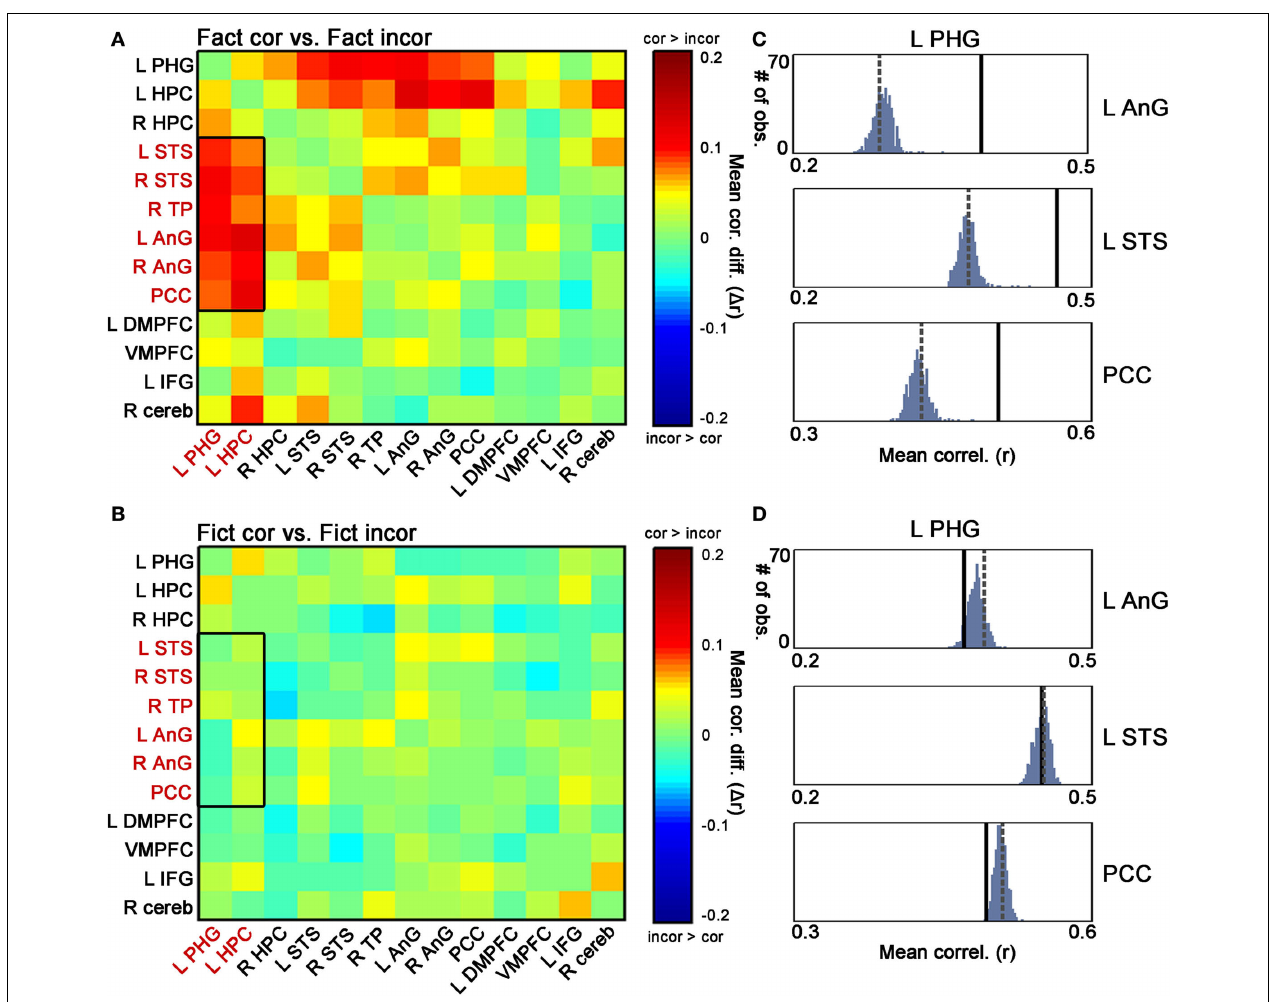
FIGURE 6 | Differential coactivation in the retrieval network as a function of retrieval accuracy. (A) Matrices denoting the differences between inter-ROI correlations of Fact_cor vs. Fact_incor . Each cell indicates the difference between mean inter-ROI correlations of BOLD responses during Fact_cor vs. Fact_incor . The rectangle here and in (B) outlines the ROI pairs of the left hippocampus/parahippocampal gyrus (PHG) and temporal/parietal cortices, for which increased functional coactivations are observed during Fact_cor compared to Fact_incor . (B) Matrices denoting the differences between inter-ROI correlations of Fict_cor vs. Fict_incor . Cells indicate the difference between mean inter-ROI correlations of BOLD responses during Fict_cor vs.